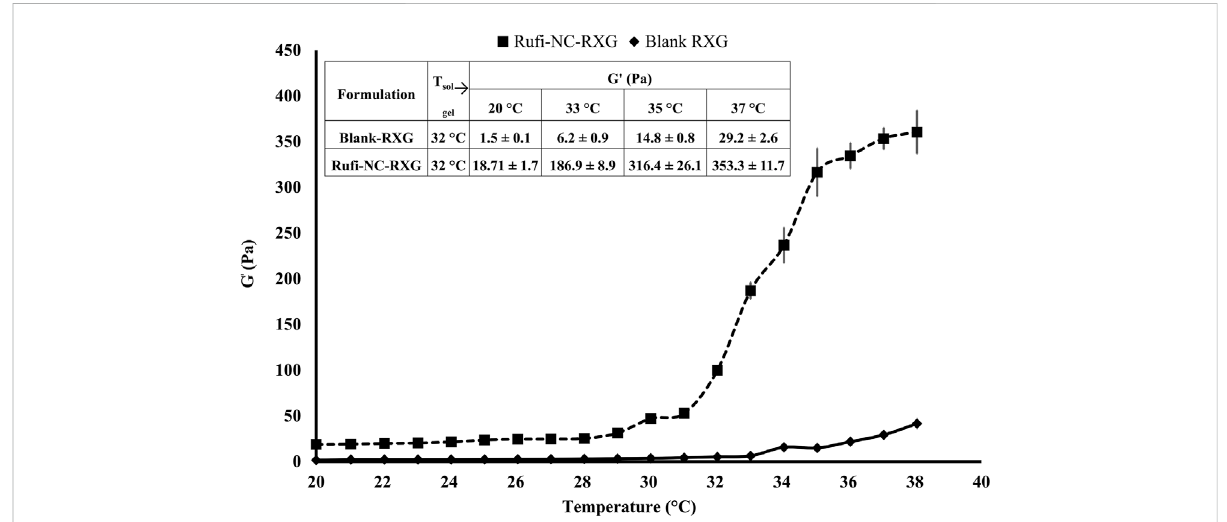
FIGURE 4 Rheological evaluation for Ru fi -NC-RXG and Blank-RXG using temperature sweep.